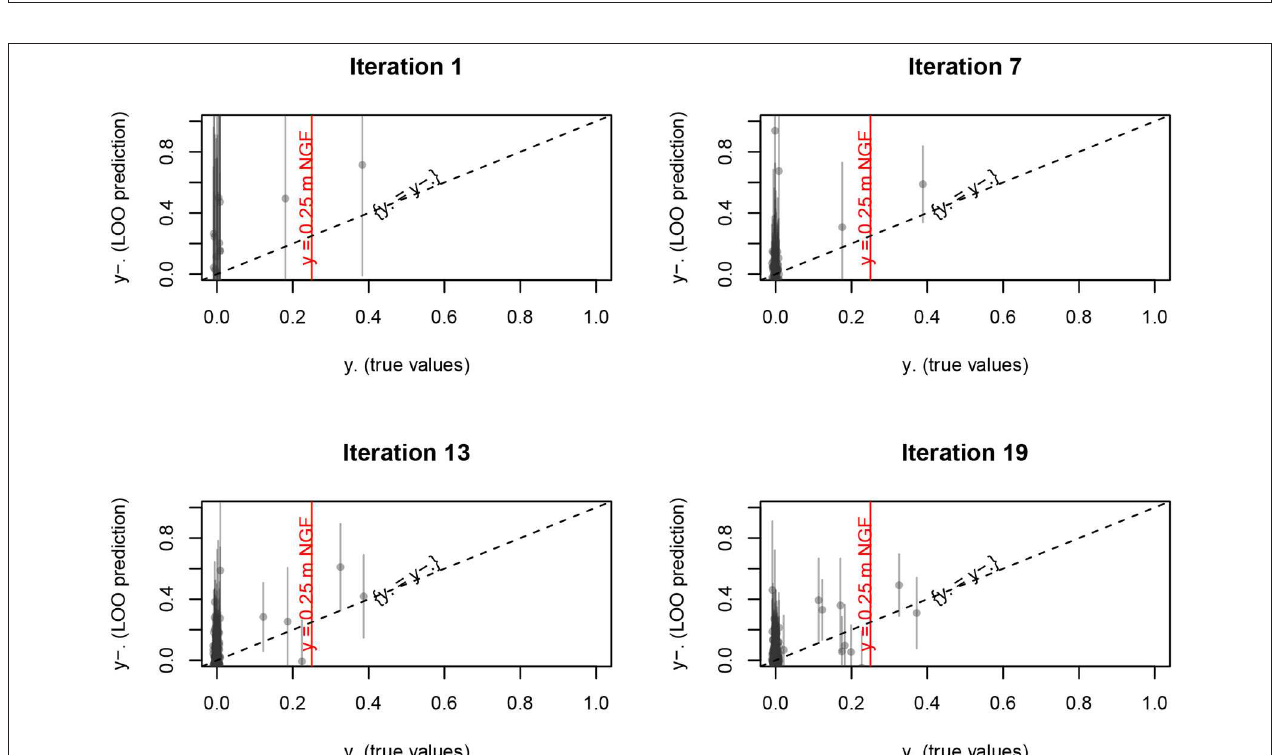
FIGURE 10 | Kriging prediction of max t ( H p 1 ) vs. true values at the last iteration (19). Gray bars are issued from kriging variance, red line is the safety target, and dashed line is unbiased prediction.